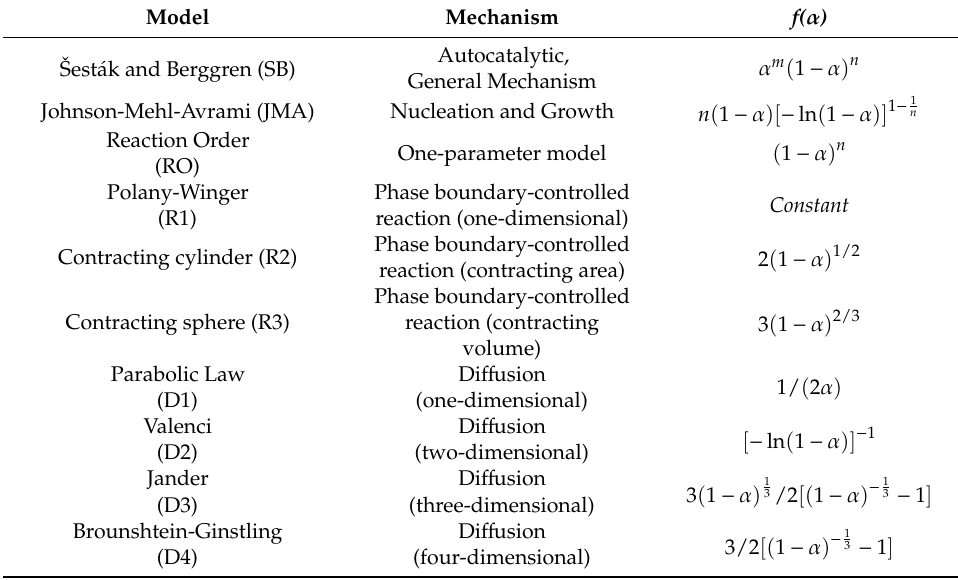
Table 1. Reaction models with their mechanisms and equations for f( α )